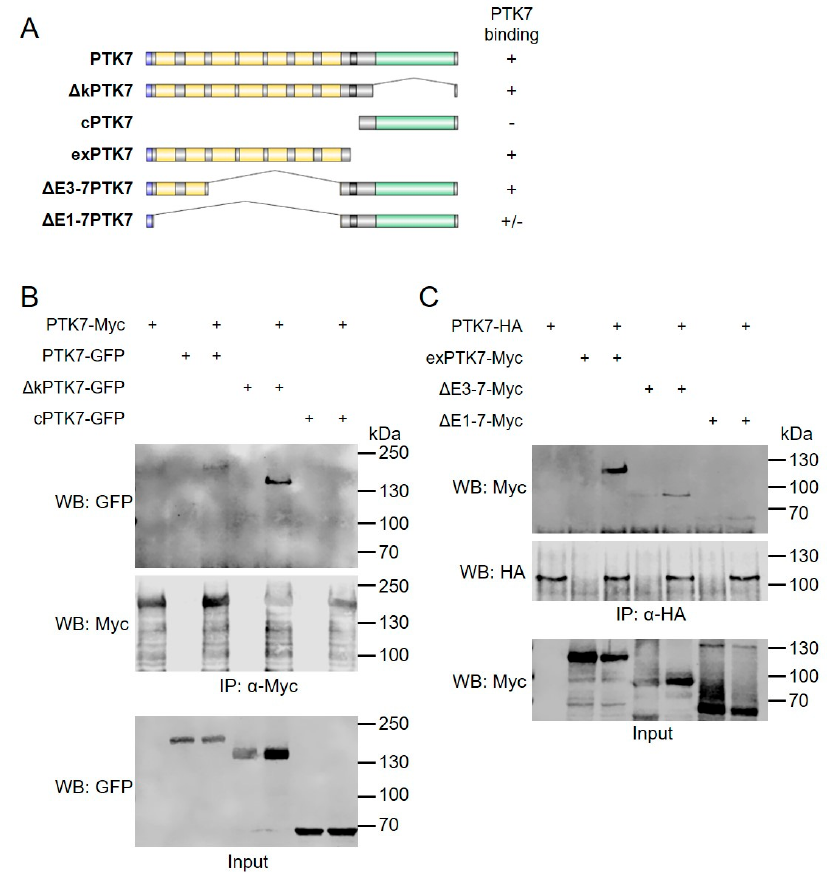
Figure 5. Ptk7 mediates homophilic binding via its extracellular domains. ( A ) Schematic overview of the respective constructs. Their ability to bind to full-length Ptk7 is indicated by (+), the lack of binding by ( − ). HEK293 cells were transfected as indicated and immunoprecipitations were performed using anti-Myc ( B ) or anti-HA antibodies ( C ). Cell lysates are shown in the bottom panel, co-immunoprecipitated proteins in the upper panel and immunoprecipitated proteins in the middle panel. Antibodies used for Western blotting (WB) are indicated on the left, molecular weights (kDa) are indicated on the right. Representative results of at least three independent experiments are shown. The quantity of PTK7 and ∆ kPTK7 co-precipitated with full-length PTK7 in respect to the respective inputs was determined by densitometric analysis (LI-COR Image Studio): mean value for PTK7: 1 for ∆ kPTK7: 2.6.